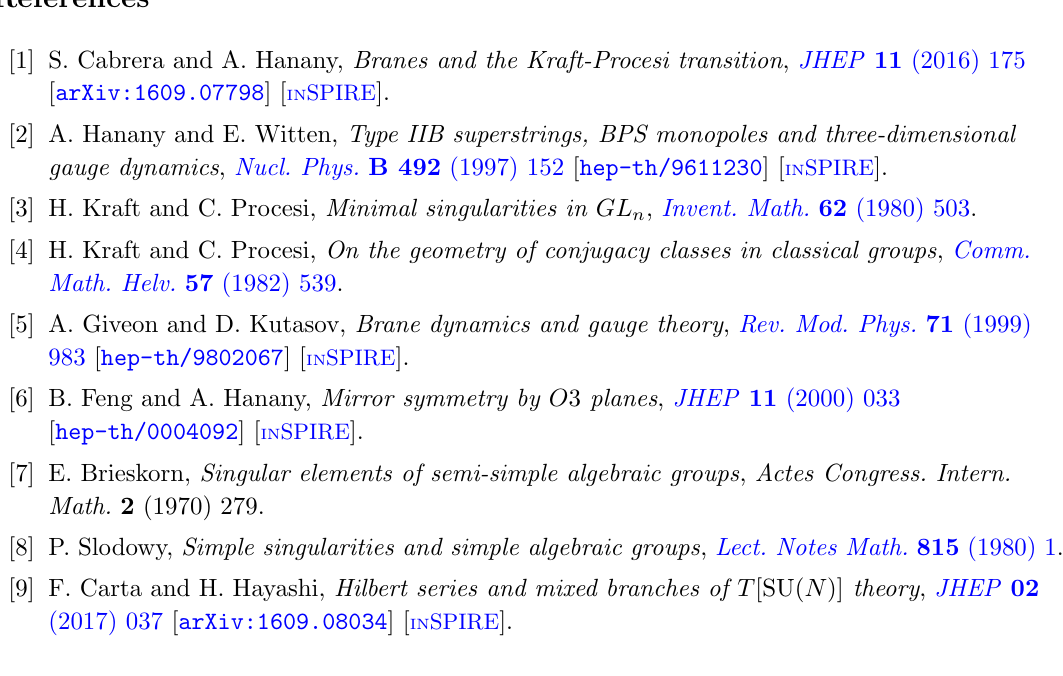
2 n (cid:0) 1 subregular